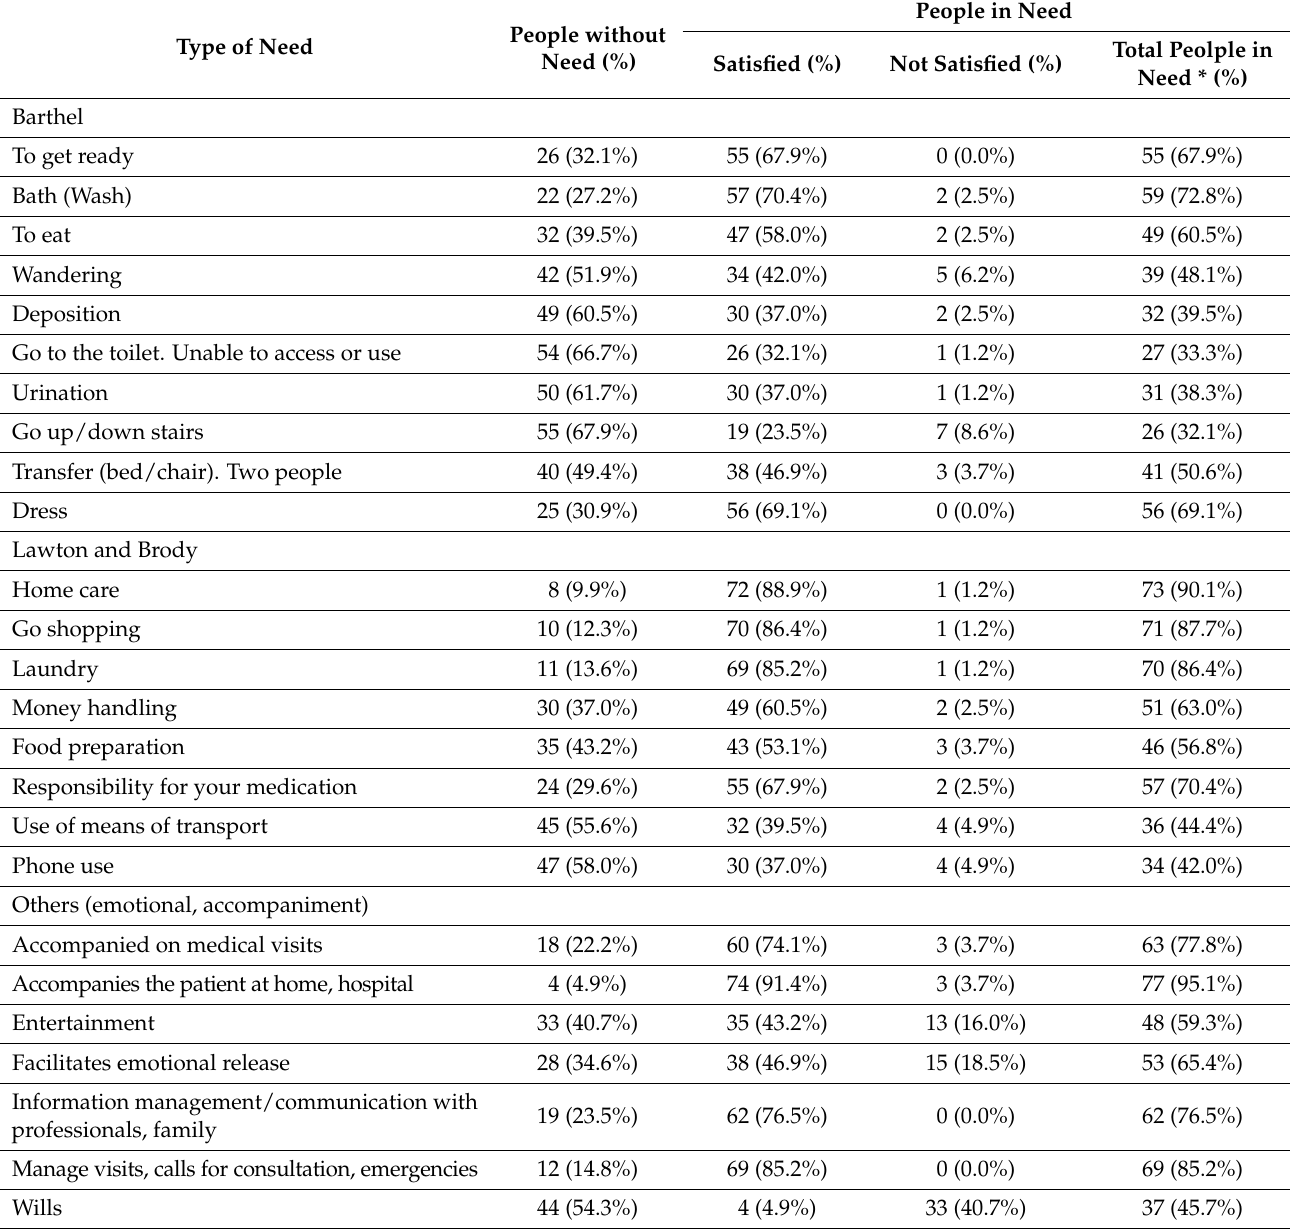
Table 3. Type of needs in the initial